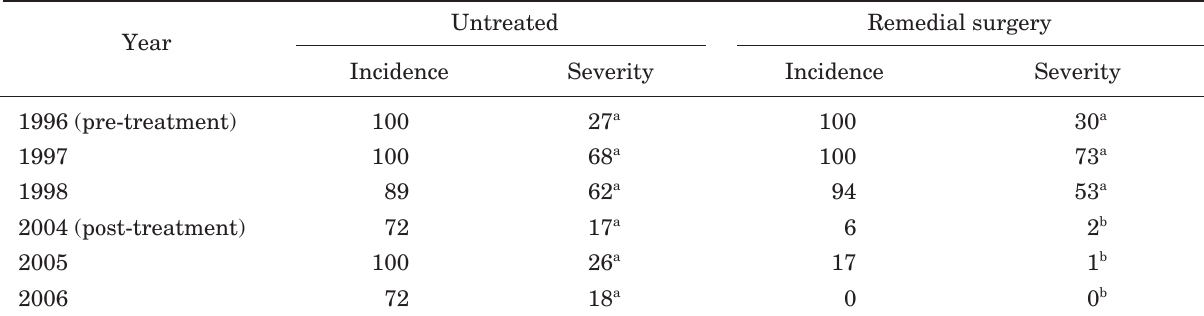
Table 2. Incidence (%) and severity (%) over time of vines with foliar symptoms of Eutypa dieback pre and post- remedial surgery which was conducted by low-cuts in 1999 on 18 ‘Shiraz’ vines in the Eden Valley, South Australia, compared with 18 vines left untreated (Trial 1). Mean values within rows followed by the same letter are not signifi- cantly different (LSD; P =0.05) Untreated Remedial surgery Year Incidence Severity Incidence